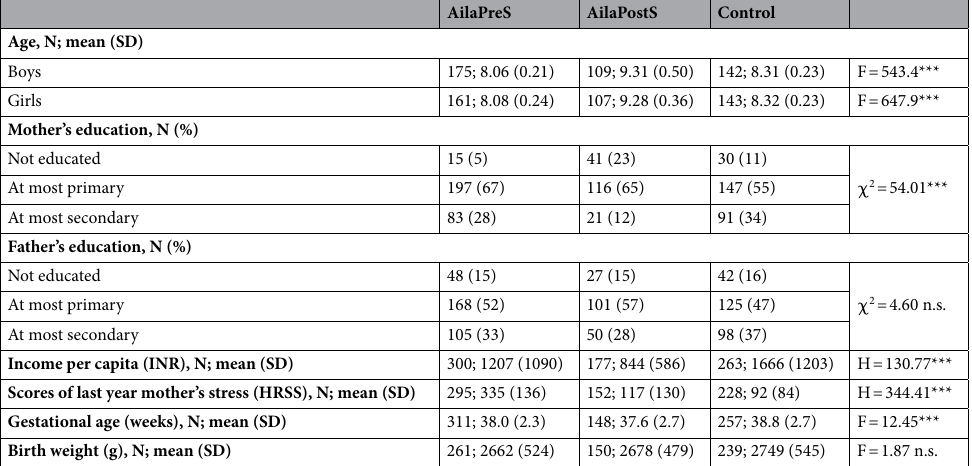
Table 1. Descriptive statistics of all confounding variables by groups. n.s. non-significant, AilaPreS prenatally Aila-exposed children, AilaPostS postnatally Aila-exposed children, Control non-exposed to Aila counterparts, H result of the Kruskal–Wallis test, F F-statistic from ANOVA test, χ 2 value of the Pearson’s’ chi square test. ***p < 0.001.